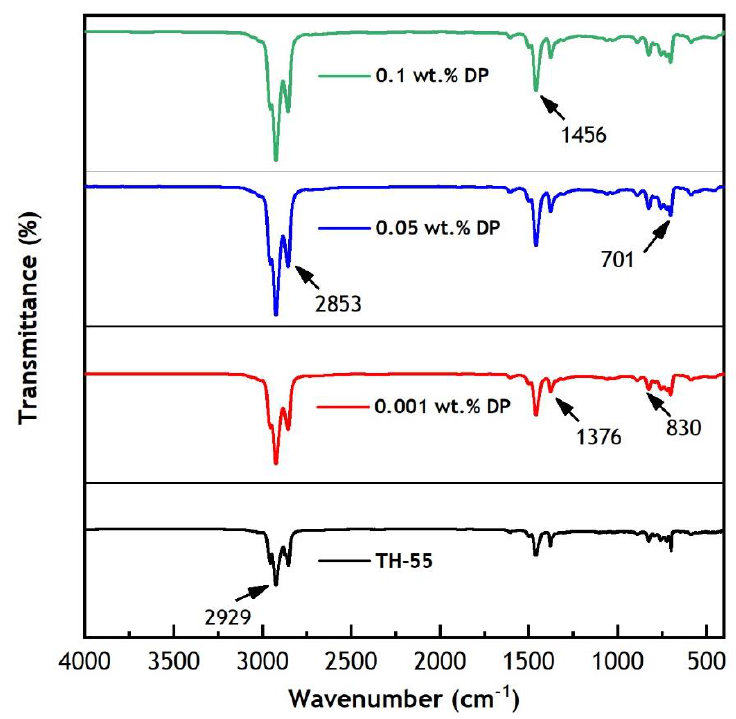
Figure 5. FT-IR spectra of TH-55 and TH-55/DP nanofluids. Diamond nanoparticles are suspended into TH-55 to enhance the absorption aptitude of the fluids so that it can improve the photo-thermal and cooling efficiencies of the hybrid CPV/T system. The optical absorption characteristics of formulated TH-55/DP NFs are examined by analyzing the UV-vis spectrums presented in Figure 6. The analysis was performed with TH-55 and several concentrations (0.001, 0.05, and 0.1 wt.%) of DP for a wavelength range of 200 to 800 nm as it contains over 80% of the total solar radiation emitted from the sun. According to the law of Beer-Lambert, the absorption property of fluid will be augmented due to the addition of solid particles into it and absorbance should be improved with increasing weight loadings of particles dispersed into the fluid [49]. Figure 6 exhibits absorption of TH-55/DP NFs intensified, notably at different peaks and on a visible wavelength scale relative to pure TH-55. Absorbance enhanced rapidly at 200–250 nm and observed high light absorbance up to 450 nm wavelength. At higher wavelengths (450–800 nm), absorbance remained steady for all the fluids, and the absorbance of NF samples remained greater than TH-55 oil. Gulzar, et al. [50] observed an analogous trend in absorption characteristics while investigating several TH-55 based NFs. The obtained average increments in absorbance for TH-55/DP NF at 0.001, 0.05, and 0.1 wt.% are 16.18, 65.28, and 120.80%, respectively. The remarkable intensification in photo-thermal efficiency is due to the absorption capacity and larger surface area of diamond particles that lead to advanced light-to-heat energy conversion behavior by the NFs [48]. The results from the UV-vis analysis indicate the superior absorption capability of the formulated NF and undoubtedly validate its potential implementation on direct absorption solar collectors, for instance, a hybrid CPV/T solar system. The findings are consistent with other nanofluids as well